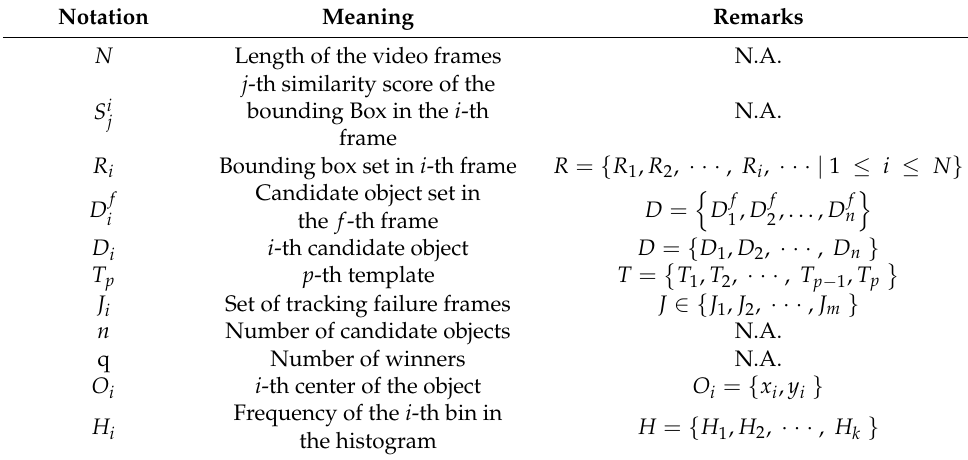
Table 2. Notation